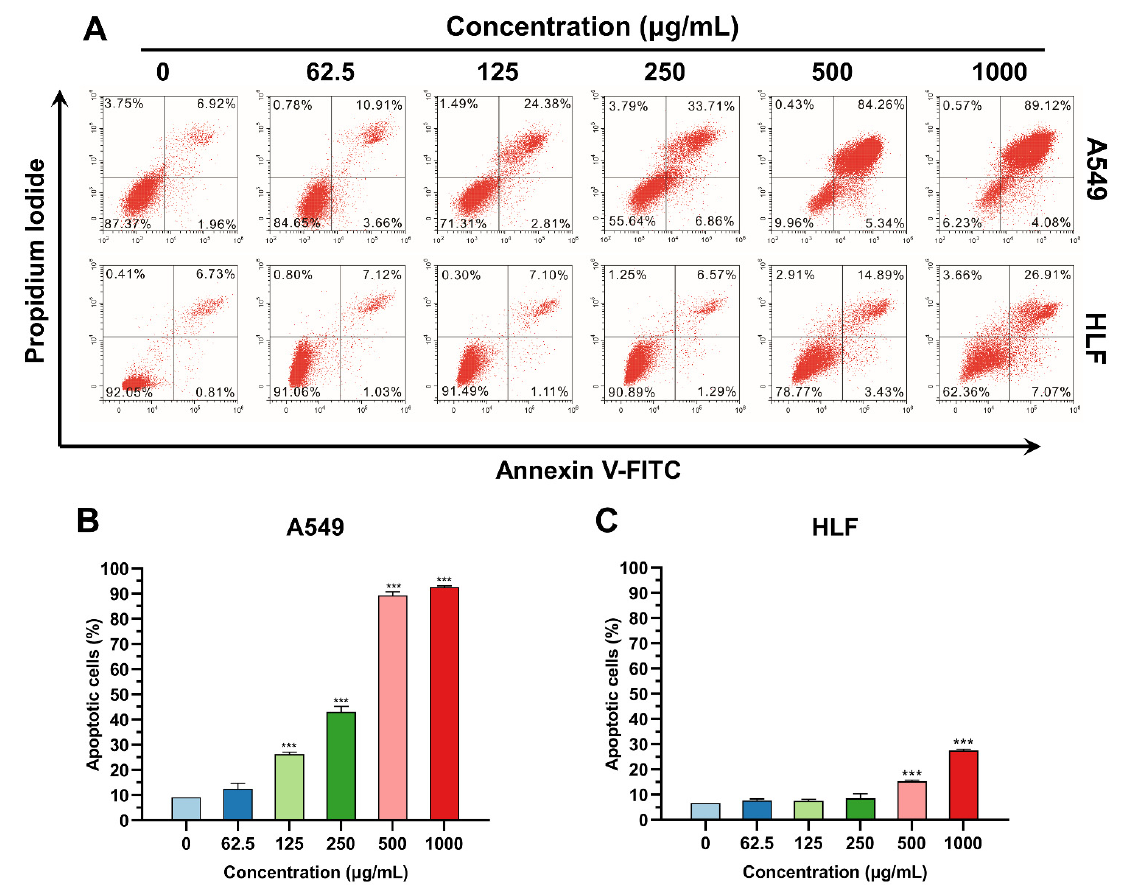
Figure 4. AnnexinV-FITC/PI double staining followed by flow cytometry was undertaken to assess the integrity of the cell membrane. ( A ) Representative flow cytometry plots suggest the apoptosis of A549 and HLF cells treated with different concentrations of K ₄ F ₆ K ₄ for 12 h. The upper right quadrant (Annexin V + /PI + ) represents the late apoptotic stage cells and the lower right quadrant (Annexin V + /PI - ) represents the early apoptotic stage cells. The total proportion of apoptotic cells (early and late) in the ( B ) A549 group and ( C ) HLF group. Data are expressed as the mean ± standard deviation. *** p < 0.001 vs. 0 μ g/mL group. Table 3. The percentage (mean ± S.D.) of apoptotic cells treated with K 4 F 8 K 4